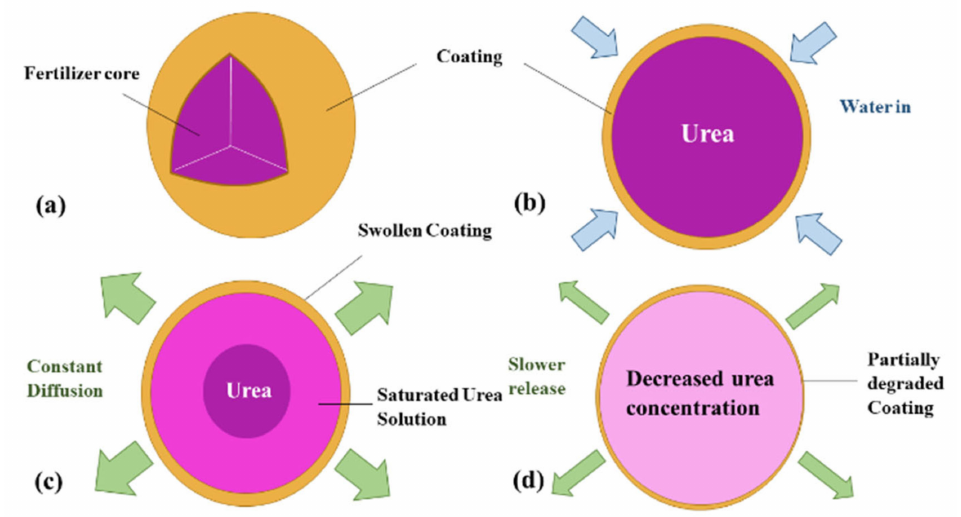
Figure 4. Mechanism of controlled release. ( a ) CRF granule. ( b ) A lag period where water penetrates through the coating to the core. ( c ) The buildup of internal pressure results in constant release to the environment. ( d ) Decay stage where concentration gradient and release rate